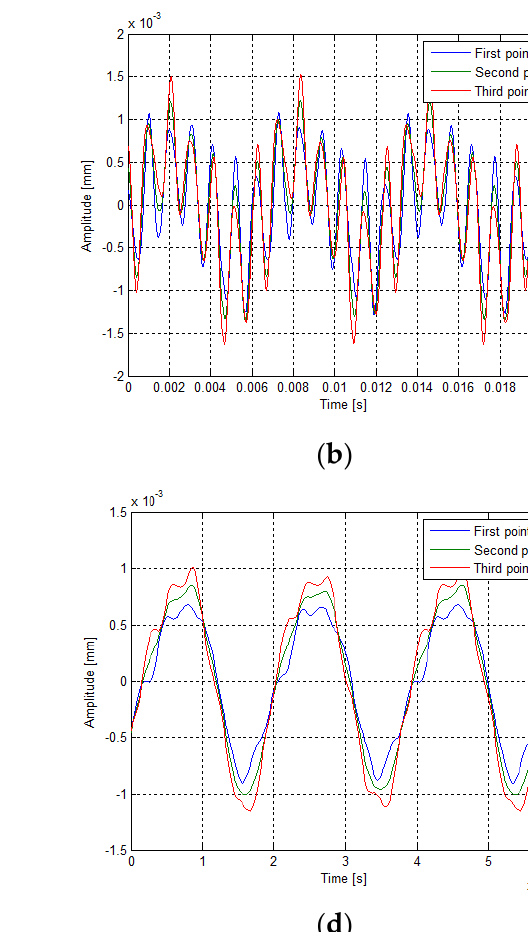
Figure 5. Vibration of the stator at specific point for two different current angles at two rotational speeds: 600 rpm ( left ) and 4500 rpm ( right ).